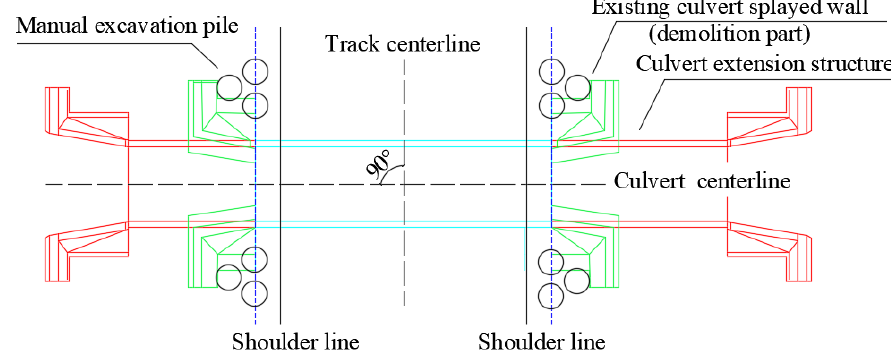
Figure 3. The original scheme of culvert extension protection.